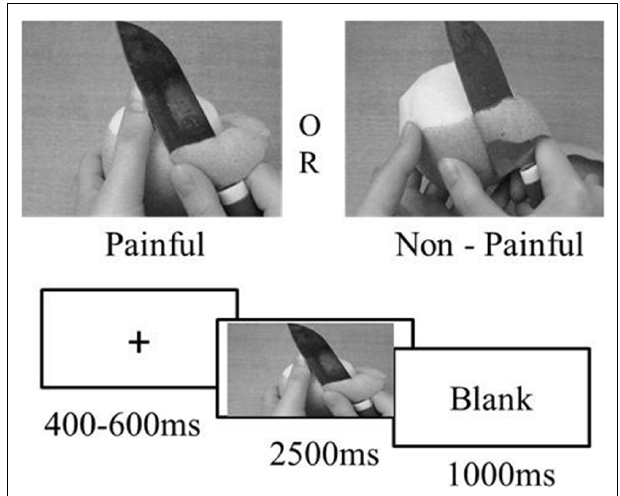
FIGURE 1 | Experimental